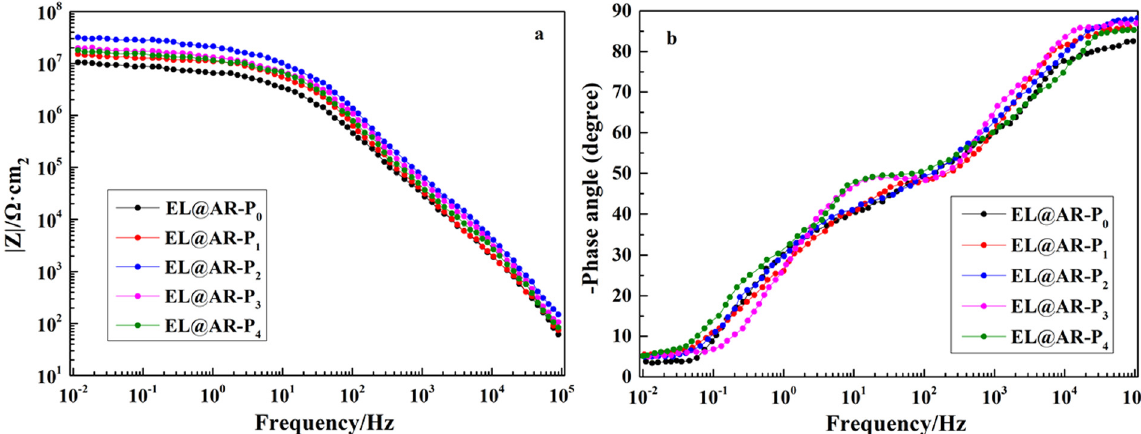
Figure 6: Bode modulus plots ( a ) , Bode phase plots ( b )